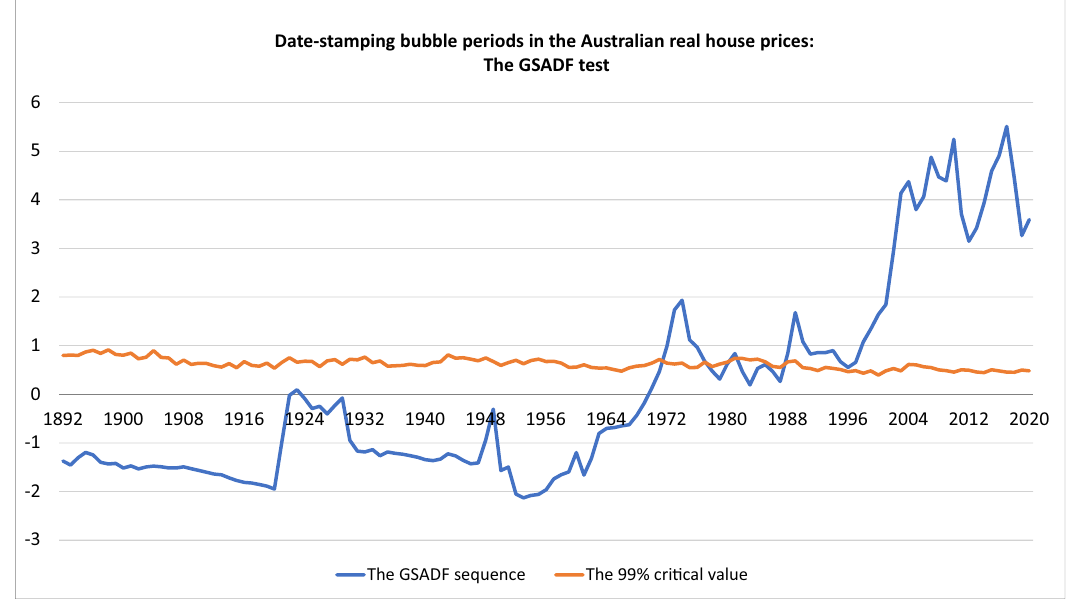
Figure 3: Date - stamping bubble periods in the Australian real house prices: The GSADF